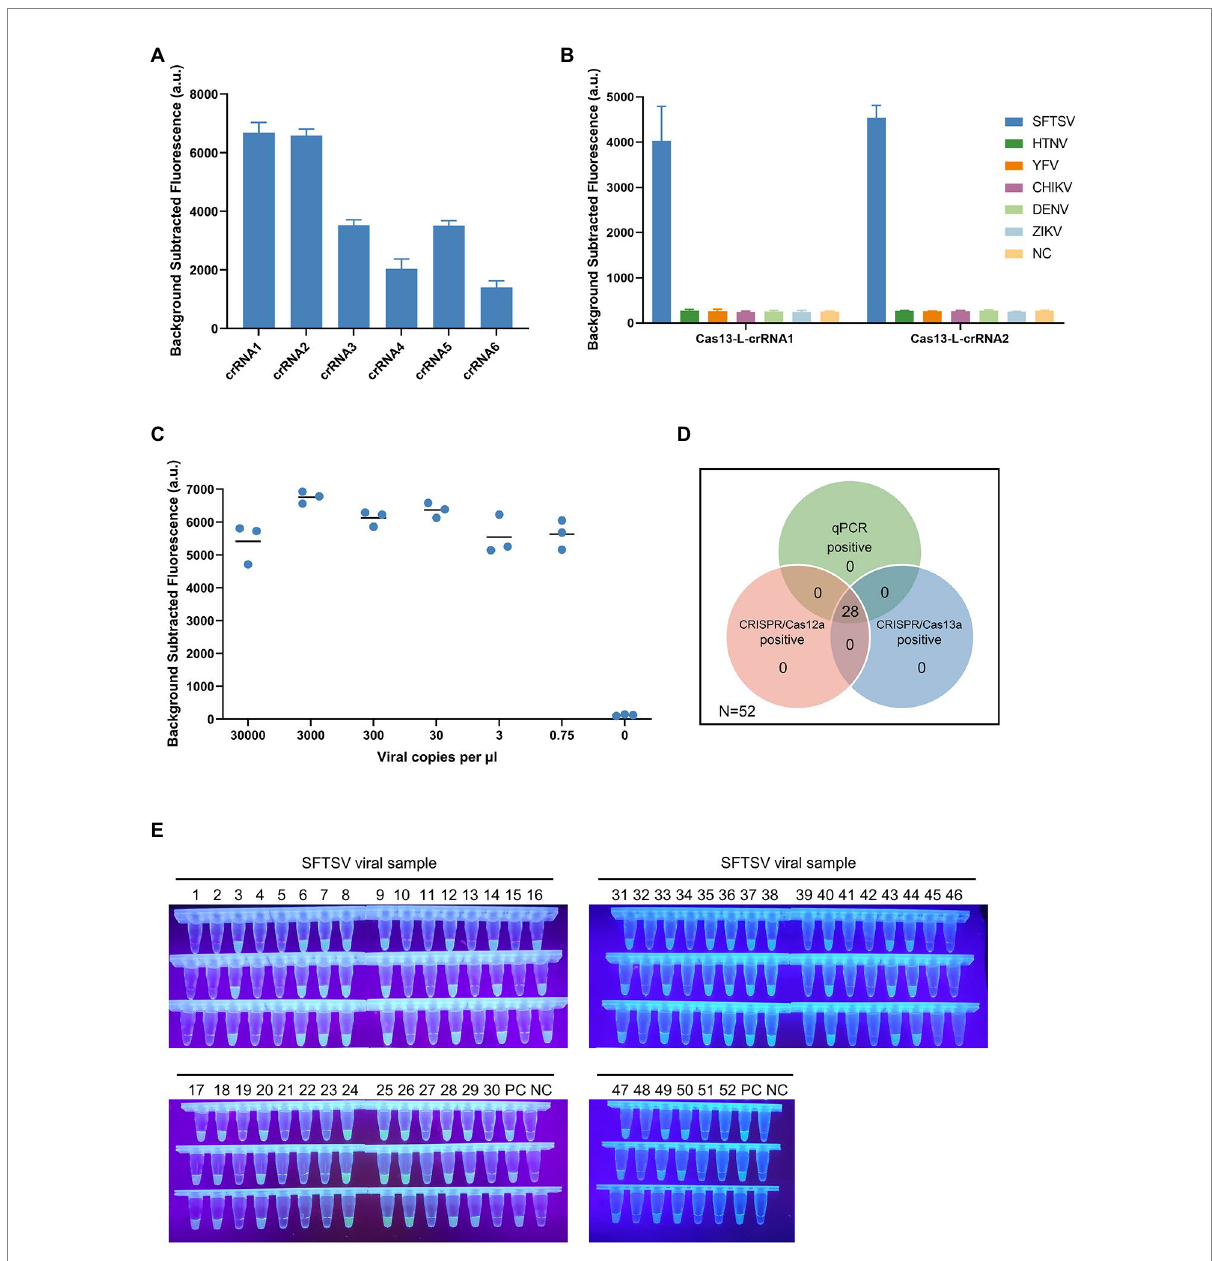
FIGURE 2 The ultrasensitive detection assay based on CRISPR/Cas13a. (A) The designed LwaCas13a-crRNAs were used to detect the targets of L gene that was amplified by primer mix. The Cas13-L-crRNA1 and Cas13-L-crRNA2 exhibited stronger signals using the same protocol. Values represent mean ± SD ( n = 3). (B) The specificity of Cas13-L-crRNA1 and Cas13-L-crRNA2. Several hemorrhagic fever viral RNA was detected parallelly using Cas13-L-crRNA1 or Cas13-L-crRNA2. The experimental results showed that there was no cross-reactivity in the detection. Values represent mean ± SD ( n = 3). (C) The sensitivity of Cas13a-based assay using Cas13-L-crRNA1. The diluted SFTSV RNA standards were used as detection targets. ( n = 3). (D) The Venn diagram showed the concordance of the results of the three assay systems on clinical samples. (E) The fluorescence visualization of the Cas13a-based assay for detection of clinical samples. A total of 52 samples were used for the evaluation. The results were observed and took pictures at 20 min for the Cas13a reaction under ultraviolet light ( n = 3). PC, positive control; NC, no-template